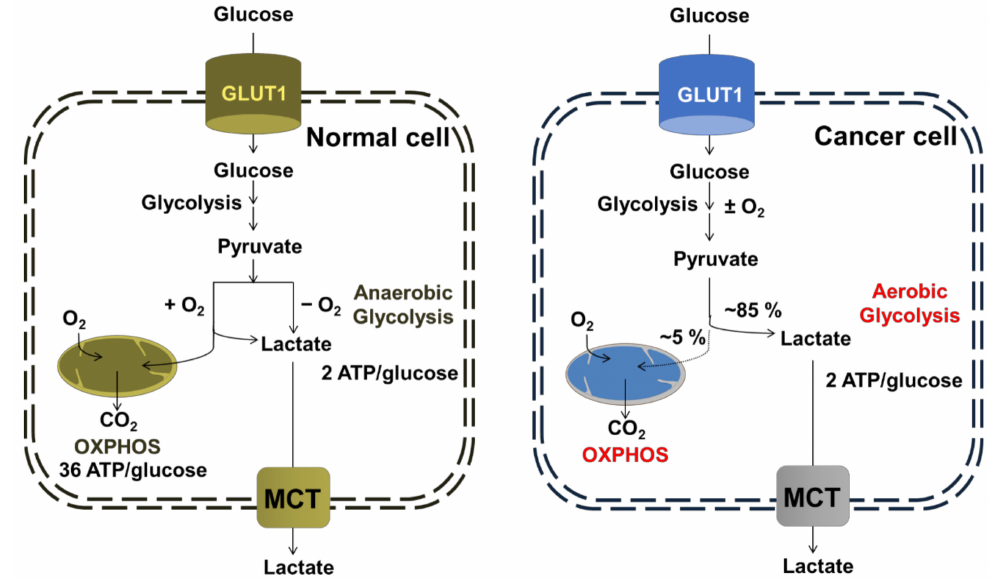
Figure 2. Metabolic activity of normal and cancer cells. The cells use glucose as their primary metabolic substrate, which is broken down into pyruvate by glycolytic enzymes, which ultimately produces adenosine triphosphate (ATP) either by glycolysis or oxidative phosphorylation (OXPHOS). In normal cells, most pyruvate is transported into mitochondria for further oxidation to produce ATP. In cancer cells, most pyruvate is converted to lactate and transported out through the MCT transporter. GLUT: glucose transporter; MCT: monocarboxylate